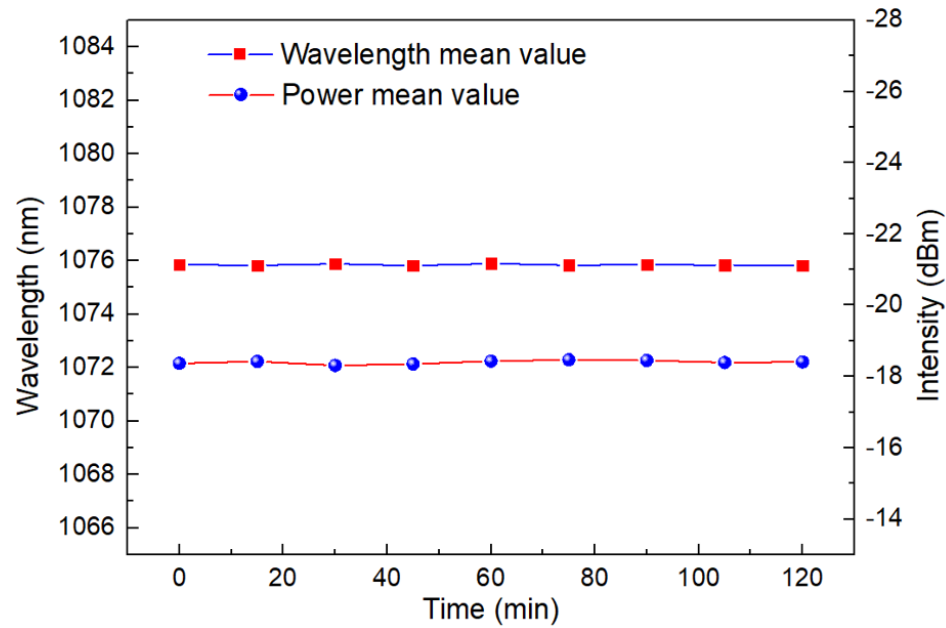
Figure 15. Laser wavelength and light intensity stability test at 10 °C.